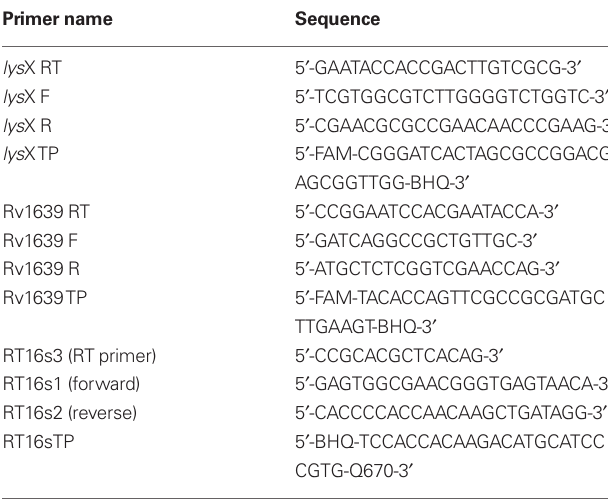
Table 1 | Primers and Taqman probes used for real-time